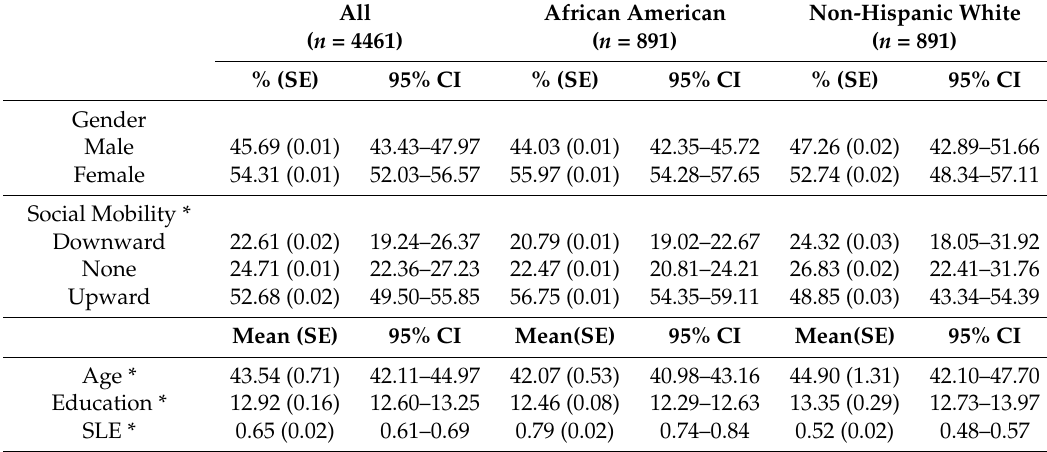
Table 1. Descriptive statistics in the pooled sample and by